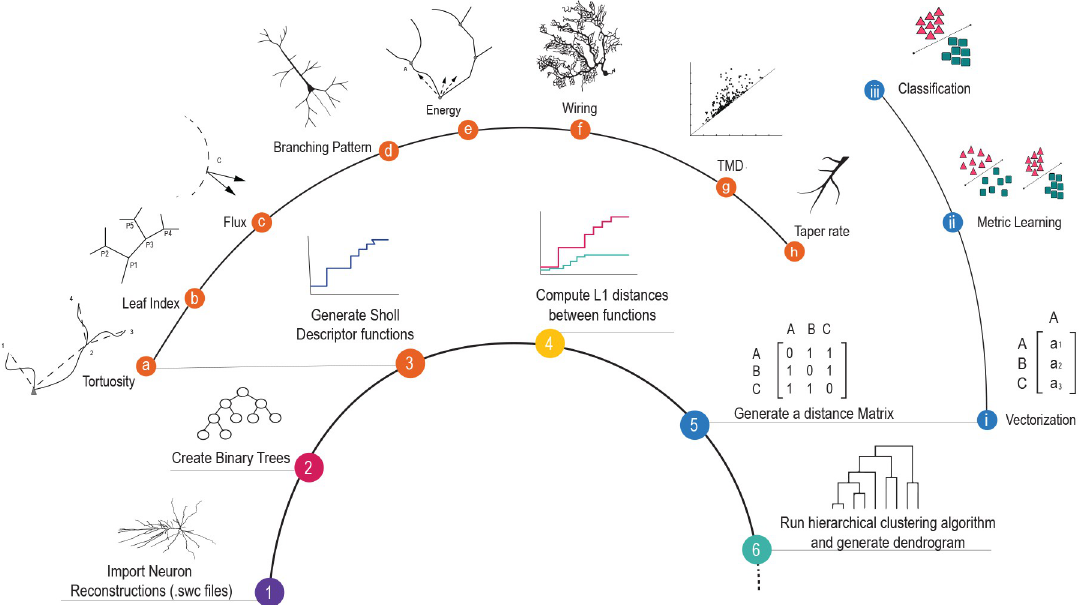
Fig 1. A process diagram to generate and cluster morphological data. Reconstructions of neuronal cell types are encoded in Sholl descriptors which are then used for clustering and classification. A representation of each Sholl descriptor is depicted in steps a-h . The process of clustering different neuronal cell types is shown in steps 1–6. Once neurons are vectorized based on descriptor metrics, we apply metric learning techniques to obtain classification (steps i-iii) .